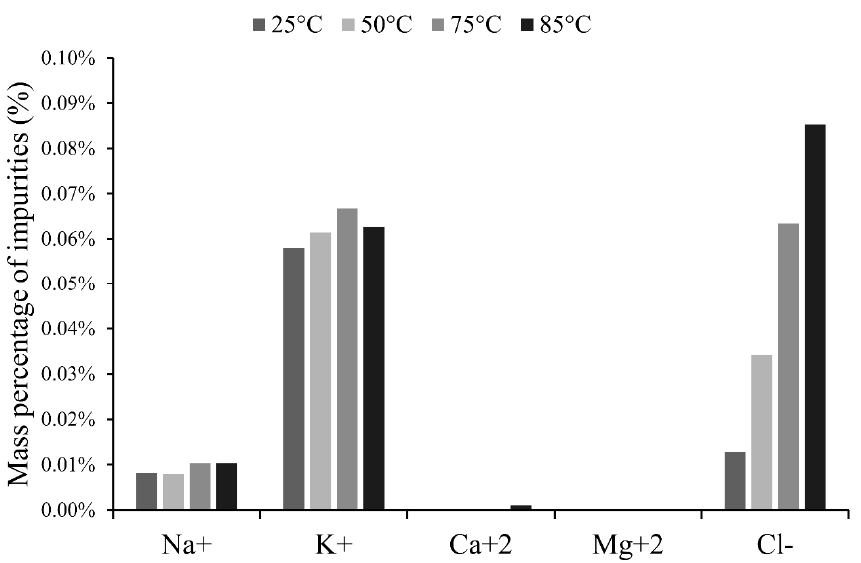
Figure 8. Mass of other ions in the final catholyte according to the